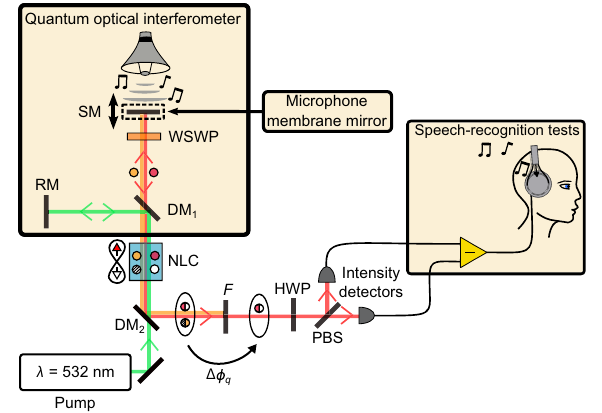
FIG. 1. The advanced quantum optical sensor. A 532-nm laser pumps a nonlinear crystal (NLC) to generate photon pair con- tributions in the forward and backward directions after reflec- tion on the reference mirror (RM). The forward-generated pair contribution acquires the two-photon phase shift induced by displacements of the sample mirror (SM). The SM can be replaced by a microphone-membrane mirror to implement